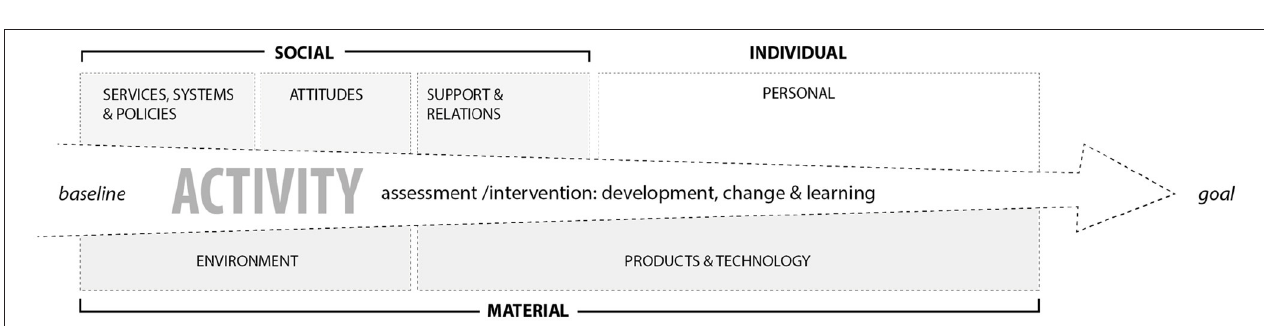
FIGURE 5 | The assessment and intervention with basis in the situated activity work as a trajectory for the change and learning processes across the different parameters, across the social, individual, and